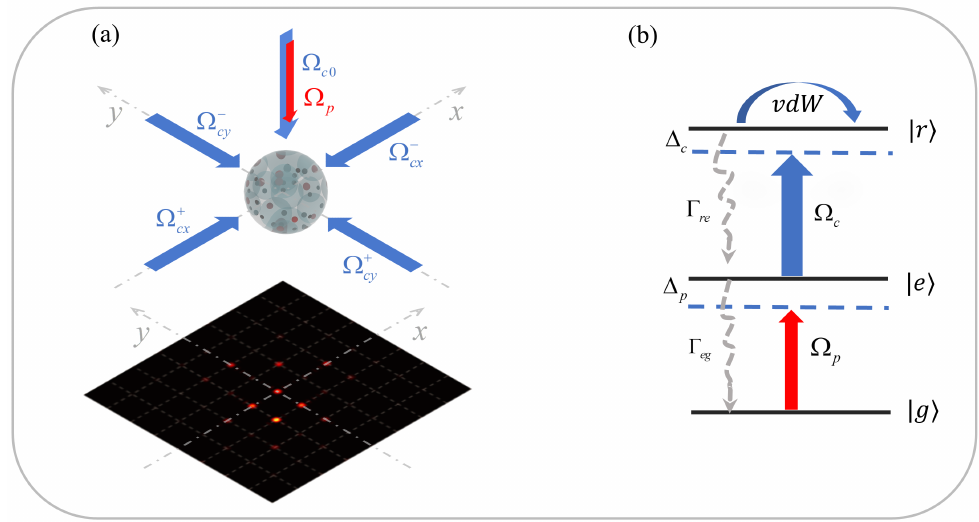
Figure 1. ( a ) Schematic of a 2D EIG realized with an ensemble of Rydberg atoms. The SW control field is applied along both x and y directions while the probe field is incident only along the z direction. ( b ) Schematic of a three-level ladder system of Rydberg atoms driven by a probe field Ω p on the lower transition and a control field Ω c on the upper transition. The three atomic states may refer, e.g., to | g (cid:105) ≡ | 5 S 1/2 , F = 2, m F = 2 (cid:105) , | e (cid:105) ≡ | 5 S 1/2 , F = 3, m F = 3 (cid:105) , and | r (cid:105) ≡ | 74 S 1/2 (cid:105) of the 87 Rb